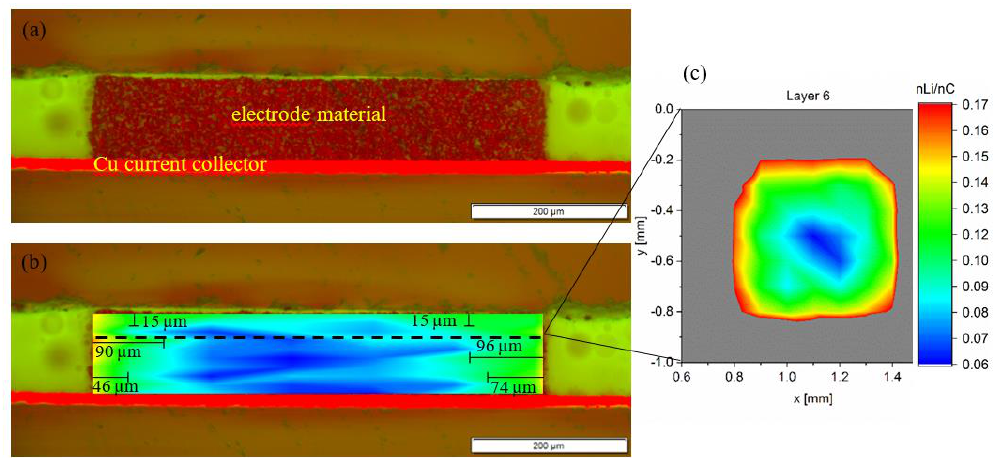
Figure 7. ( a ) Original cross-section of a micro-pillar structure, ( b ) Li-concentration depth profile of a micro-pillar structure, and ( c ) cross-sectional lithium concentration at layer 6. The electrode was lithiated at 0.01 V by applying 1 C.